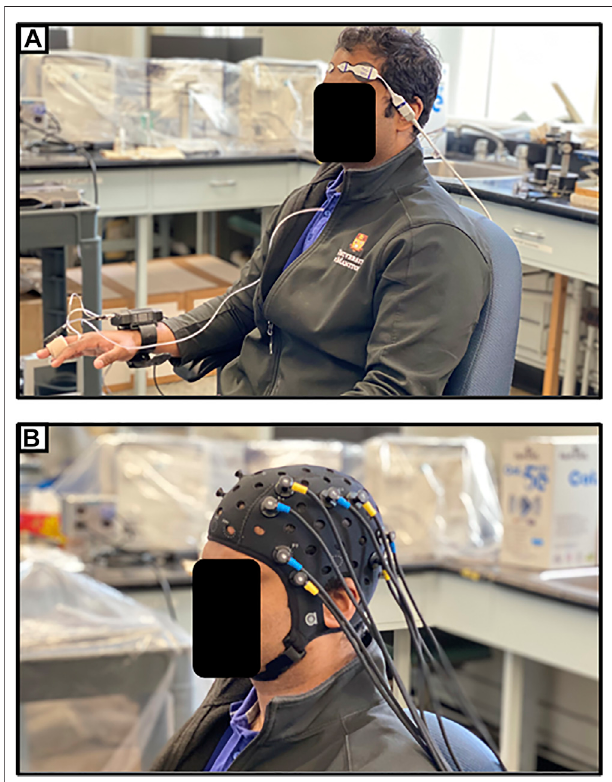
FIGURE 4 | (A) Entirely non-invasive setup for measuring cerebrovascular reactivity using near-infrared spectroscopy (NIRS) and continuous non-invasive blood pressure monitoring (NIBP). (B) Typical multi- channel functional NIRS (fNIRS) device setup. Both as demonstrated on fi rst